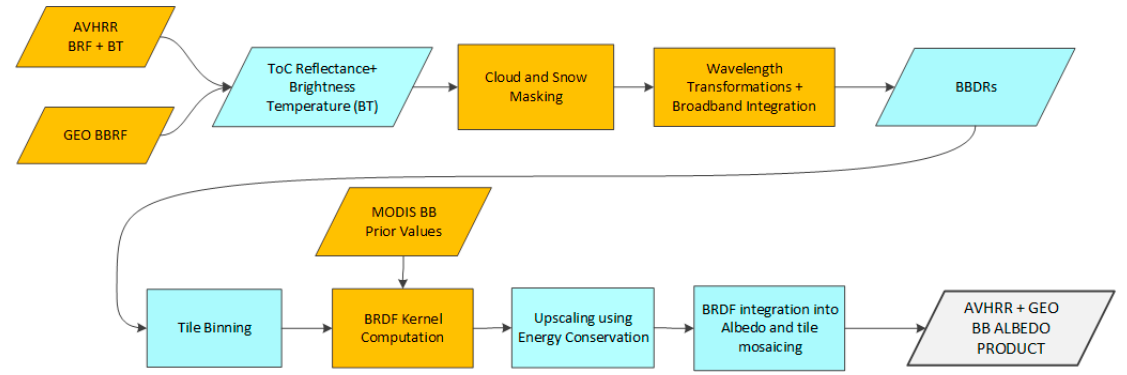
Figure 4 . QA4ECV broadband albedo product top-level traceability chain. AVHRR: advanced very high-resolution radiometer; BRF: bidirectional reflectance factor; GEO: geostationary satellite; ToC: top of canopy; BBRF: broadband reflectance factor; BBDR; broadband directional reflectance; MODIS: moderate resolution imaging spectro-radiometer; BB; broadband; and BRDF: bidirectional reflectance distribution function.